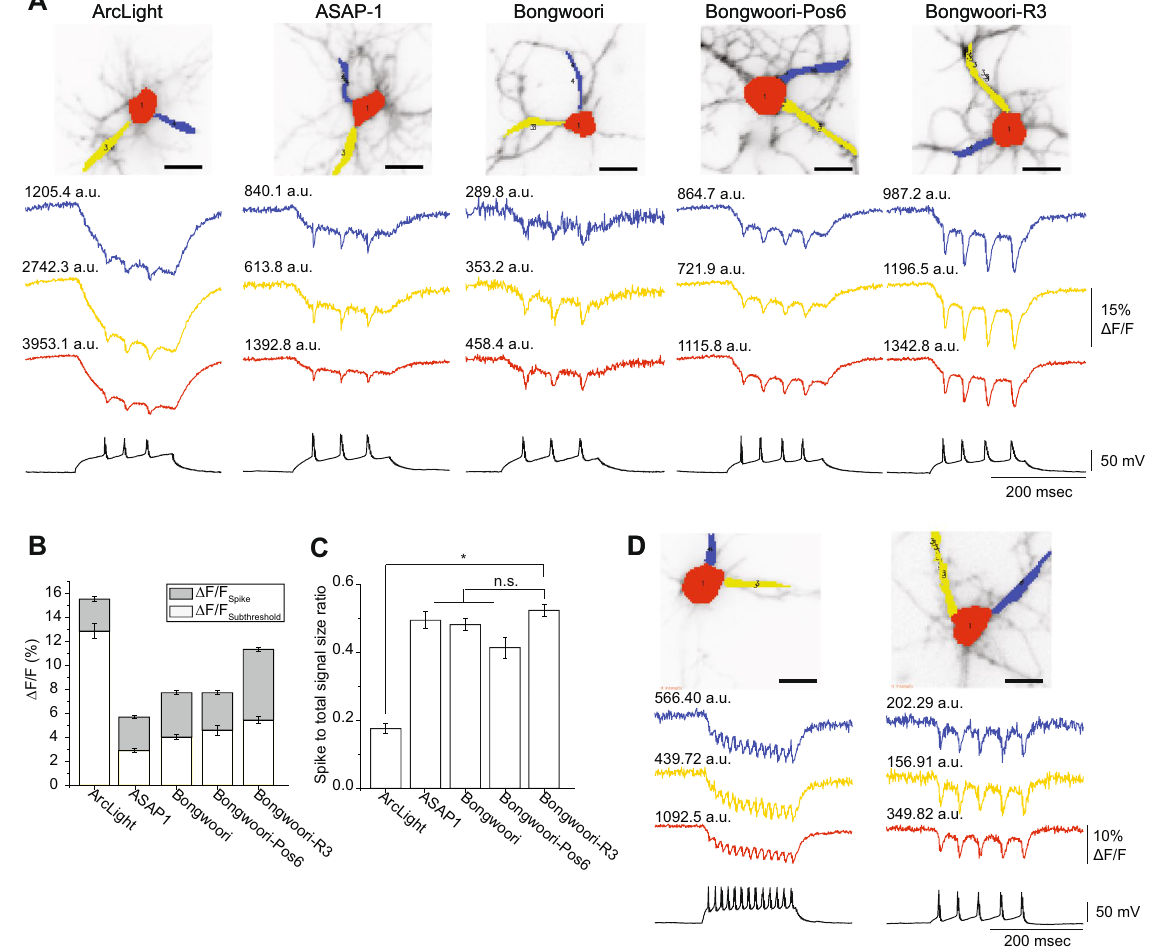
Figure 5. Comparison of different GEVIs’ ability to resolve action potentials. ( A ) Optical traces from three different regions (soma – red, processes – blue and yellow) of cultured mouse hippocampal neurons expressing either ArcLight, ASAP-1, Bongwoori, Bongwoori-Pos6, or Bongwoori-R3 under whole cell current clamp mode. Numbers above each trace refer to the fluorescence intensities (a.u., arbitrary unit) of the chosen pixels. ( B ) Comparison of the signal size of different GEVIs averaged from pixels corresponding to the soma. The bottom white area of the bar graph depicts the size of the optical response to subthreshold depolarization of the plasma membrane. The gray shaded region corresponds to the size of the optical signal during the spike of the action potential. ( C ) Spike to total signal size ratio of the optical signal averaged in ( B ) (n.s., not significant). ( D ) Two hippocampal neurons expressing Bongwoori-R3. The cell on the left is firing at 65 Hz. The cell on the right exhibits lower fluorescence but still yields a robust optical signal in response to action potentials. Error bars and shaded area are standard error of the mean. The number of action potentials (technical replication) averaged for each cell analyzed in Fig. 5B and C are as follows; 3, 5 and 4 for ArcLight, 5, 3 and 4 for ASAP1, 3, 3 and 5 for Bongwoori, 4, 4 and 3 for Bongwoori-Pos6 and 4, 4 and 4 for Bongwoori-R3. The p-values for Fig. 5C were 0.0349 for ArcLight and Bongwoori-R3, > 0.9999 for ASAP-1 and Bongwoori-R3, > 0.9999 for Bongwoori and Bongwoori-R3, and 0.8284 for Bongwoori-Pos6 and Bongwoori-R3. The asterisk in C indicates a statistically significant difference between the means compared ( * p < 0.05). Scale bar = 20 µ